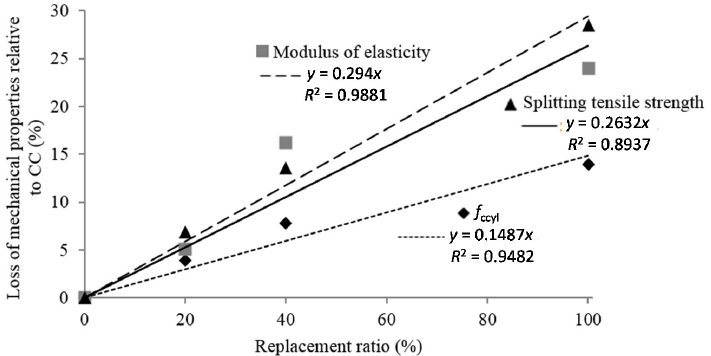
Figure 8. Loss of mean compressive strength, tensile strength, and modulus of elasticity relative to control concrete (CC) in relation to the replacement ratio.